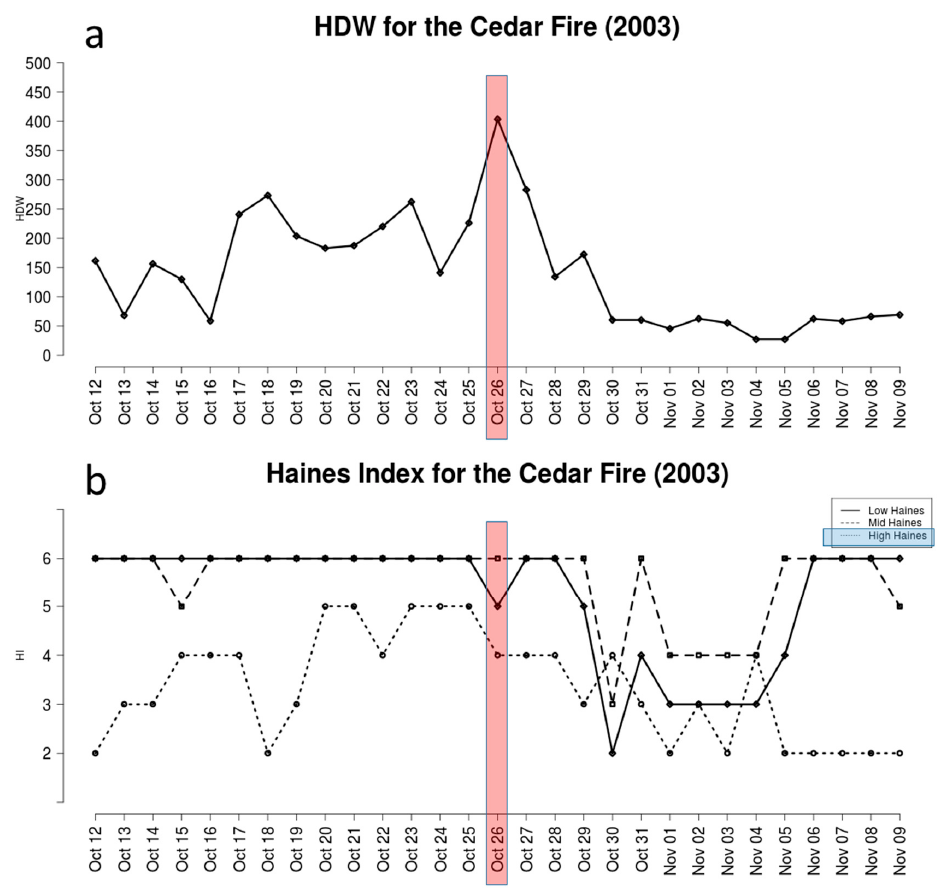
Figure 4. Time series using CFSR data at 33.0 ◦ N latitude and 116.5 ◦ W longitude from 12 October through 9 November 2003 of ( a ) HDW and ( b ) Low (solid line), Mid (dashed line), and High (dotted line) variants of the Haines Index. The vertical, shaded, red rectangles indicate the day on which the most rapid fire growth occurred on the Cedar Fire. The Haines Index variant that is recommended for this location is shaded in